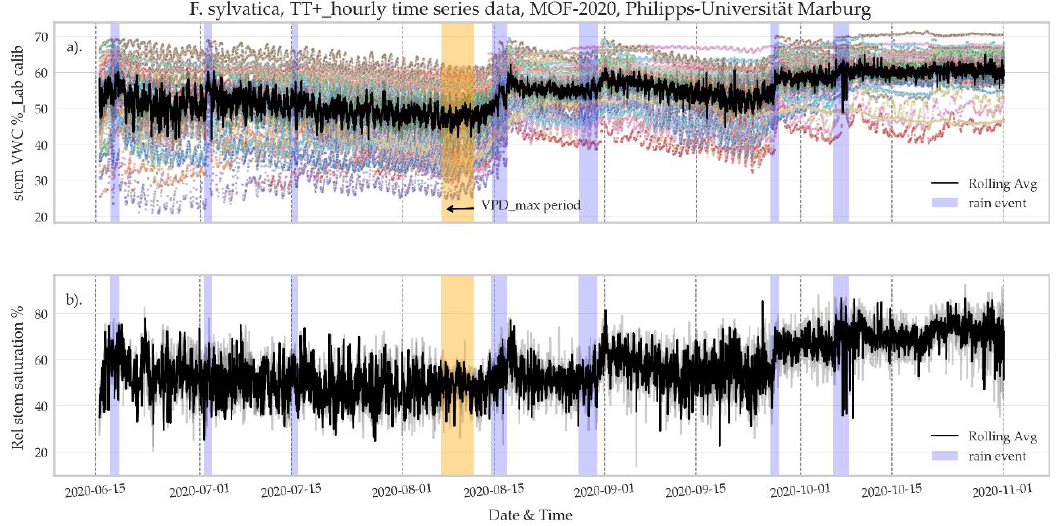
Figure 12. Seasonal variability of ( a ) stem VWC for all individuals (colored points) and combined rolling average using all data (black), ( b ) relative stem saturation index % based on a combined rolling average across all individual data. All data are derived from hourly data by TT+, species Fagus sylvatica L. in the MOF study area.